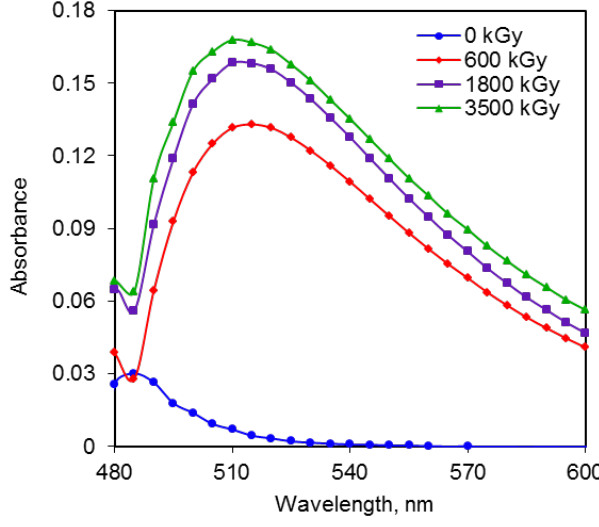
Figure 2. Absorbance of reducing sugars for control and irradiated